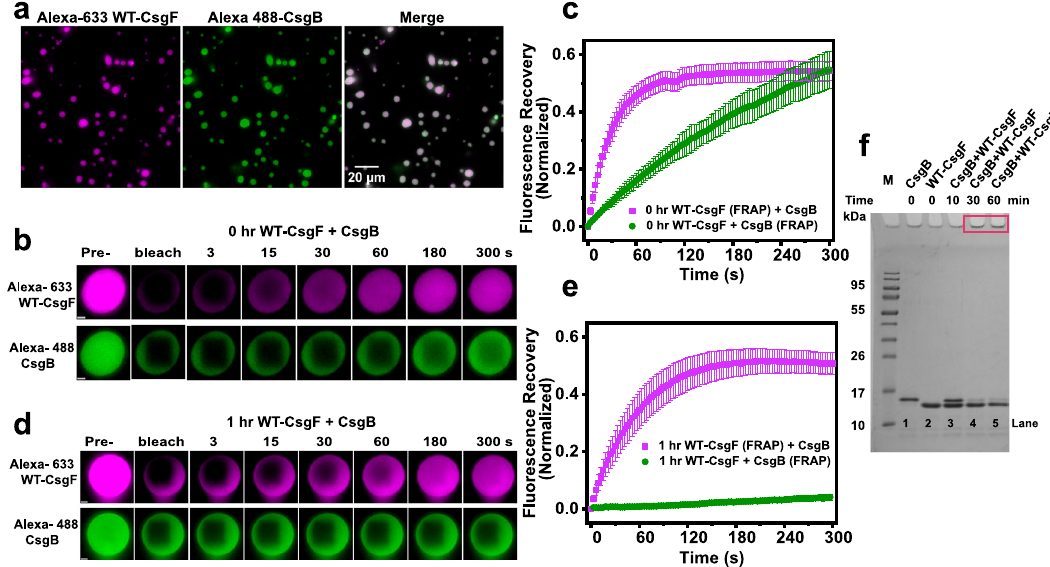
Fig. 6 | CsgB localizes in CsgF condensates. a Fluorescence images of Alexa-633- WT-CsgF (20 µ M) and Alexa-488-CsgB (20 µ M). Unlabeled to labeled protein molar ratio used was 50:1. The imaging was carried out three times with similar obser- vations. b FRAP on WT-CsgF and CsgB immediately after mixing. Scale bar: 1 µ m. c Quanti fi cationof fl uorescencerecoveryofCsgFandCsgBfor0hsample.Thedata represent mean±SD, n =3. d FRAP measurements on WT-CsgF and CsgB 1h after